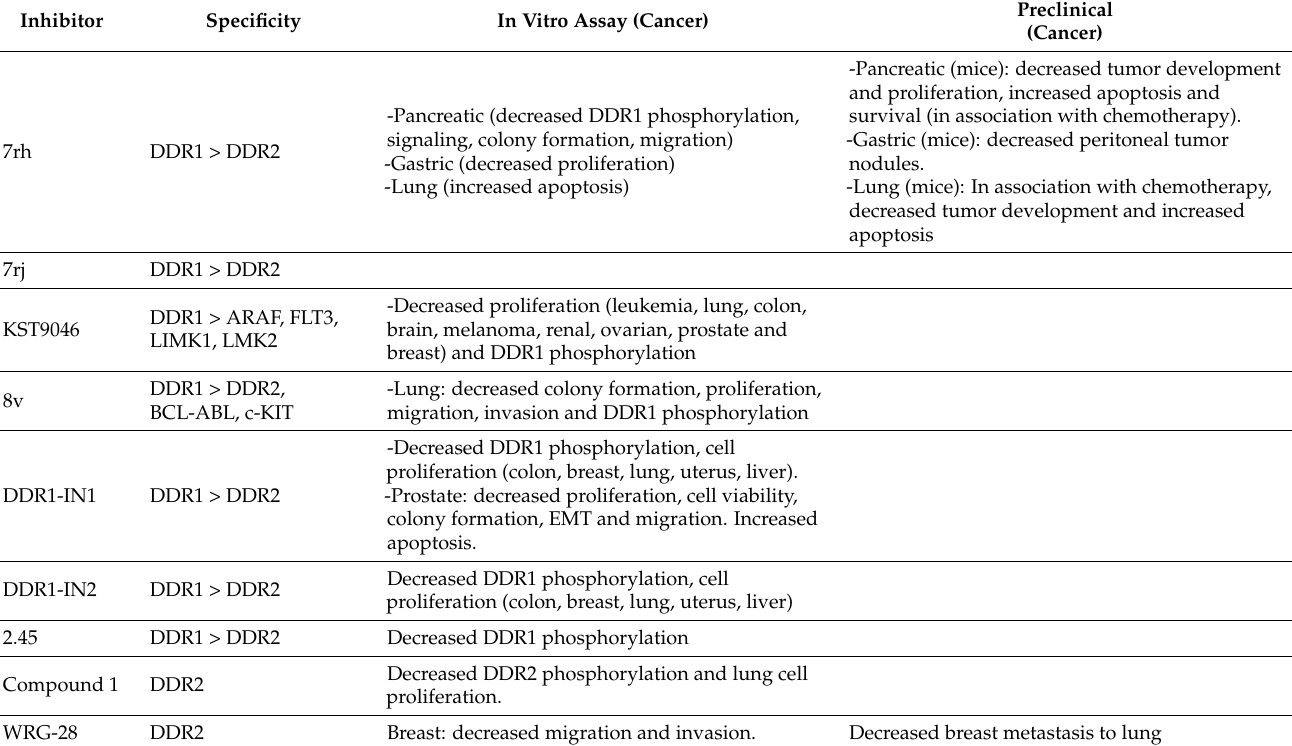
Table 6. Specific DDR inhibitors and some examples of their used in preclinical assays. Specificity describes the strength of binding between a receptor and an inhibitor and it is measured by the dissociation constant ( K D